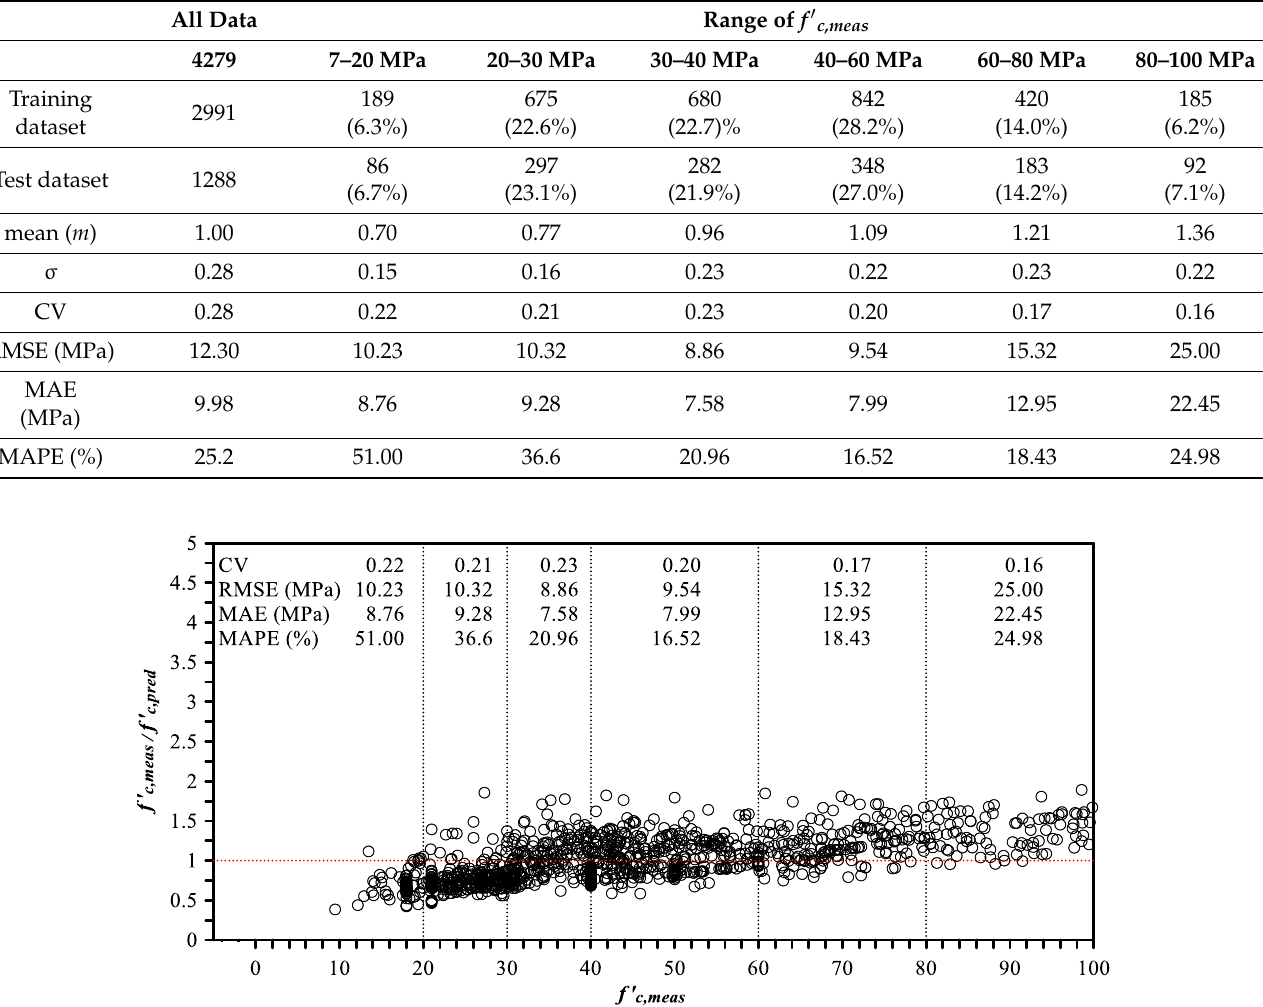
Table 2. Analysis accuracy of ML trained with f (cid:48) c,meas in all ranges.